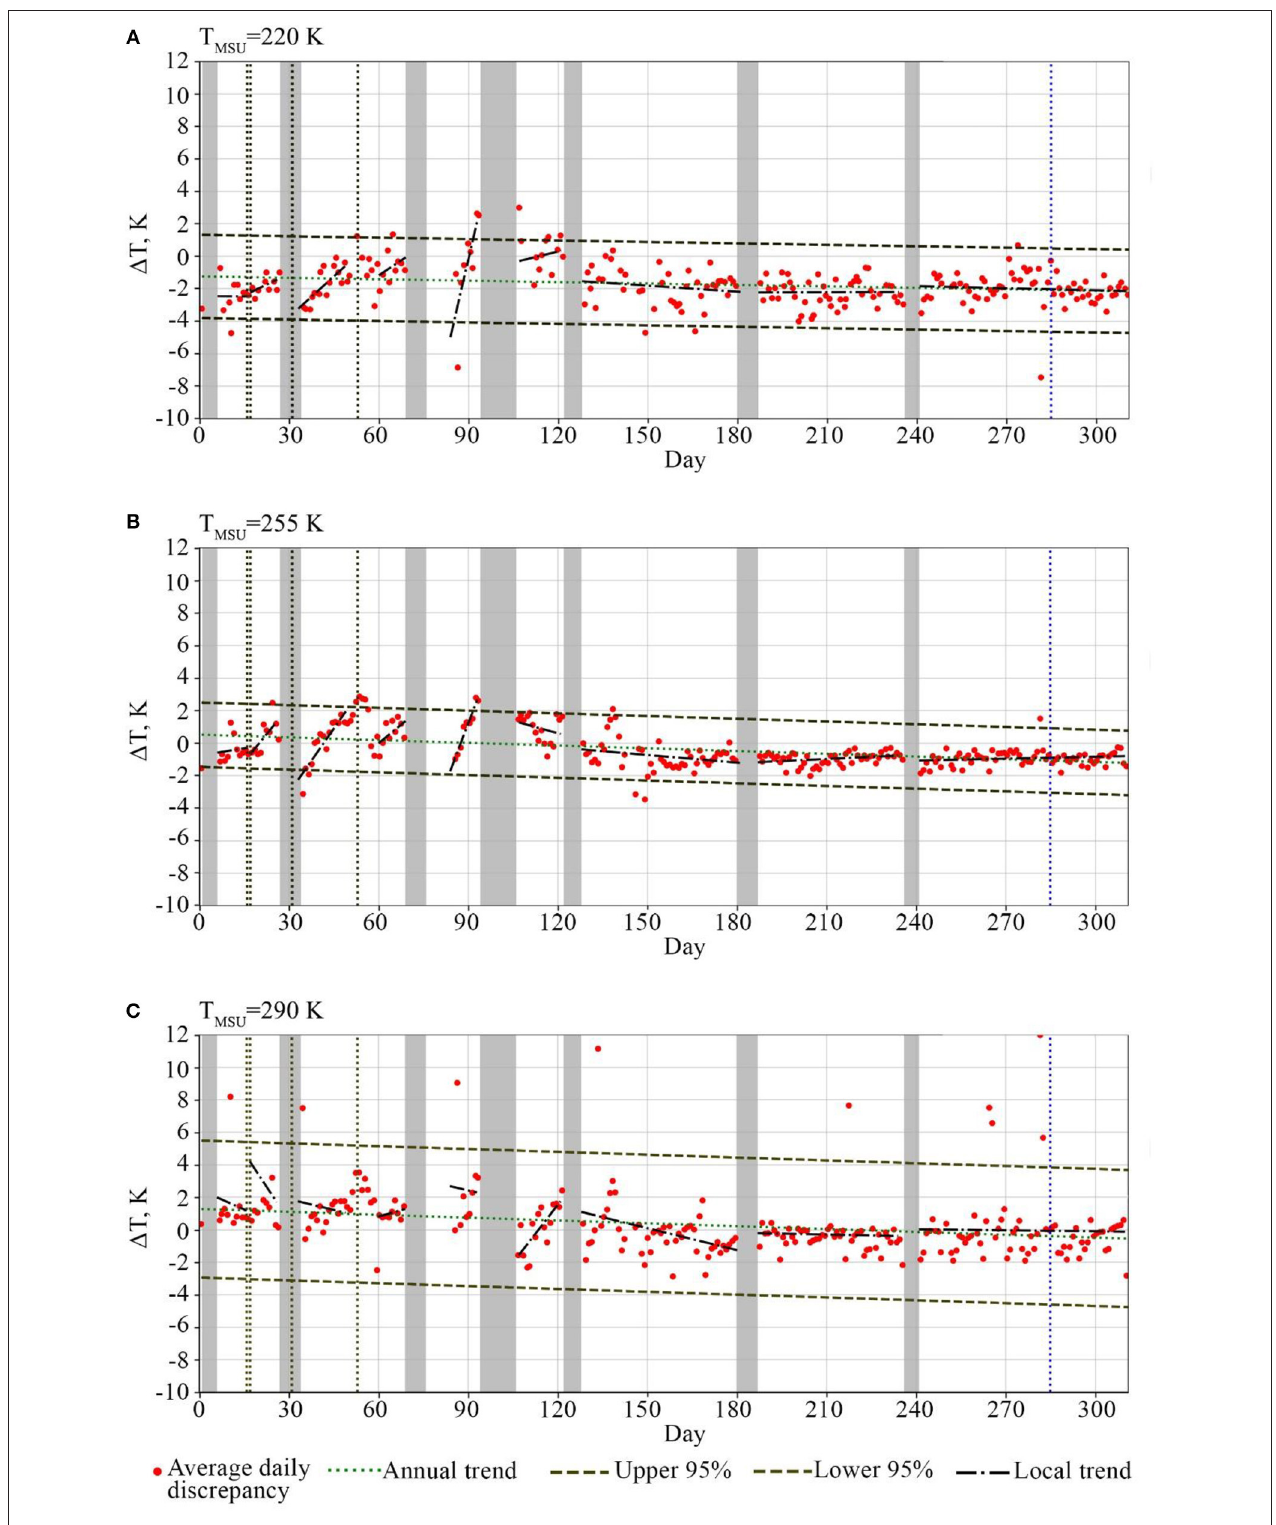
FIGURE 3 | Annual variety of calibration differences for three BTs measured in channel #9 MSU-GS ( A –220 K; B –255 K; C –290 K).